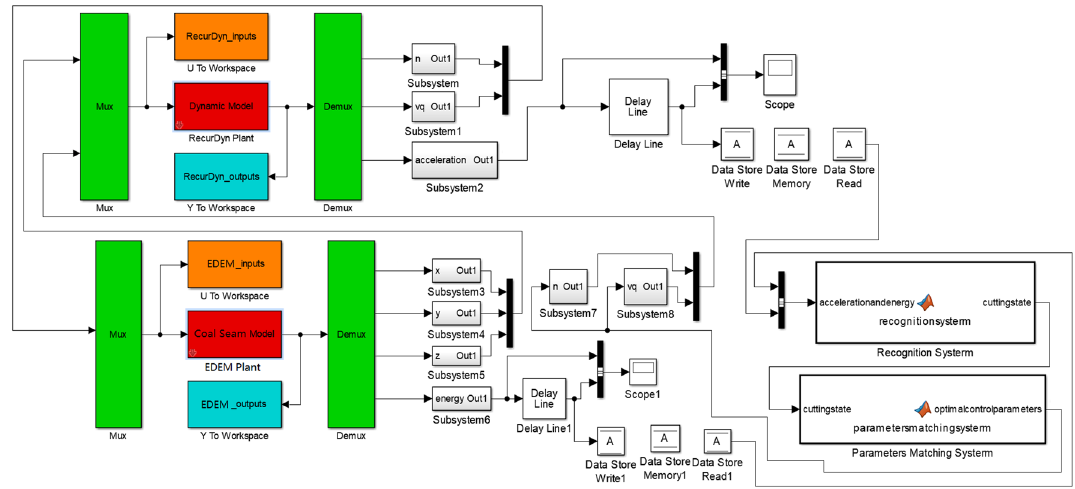
Figure 12. Multi-directional coupling collaborative simulation test platform for coal and rock